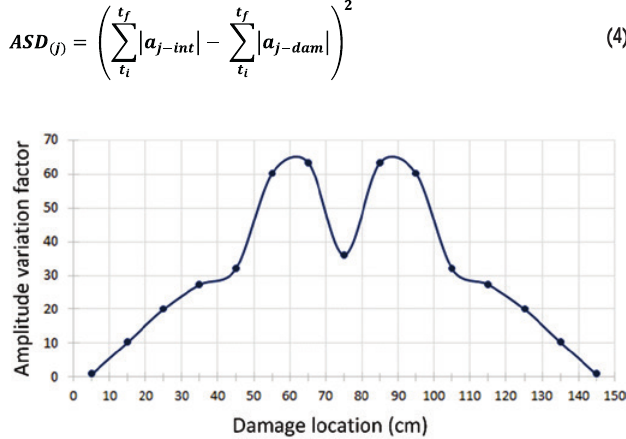
Amplitude variation factor of MCD method versus the position of the damage in the model with only one